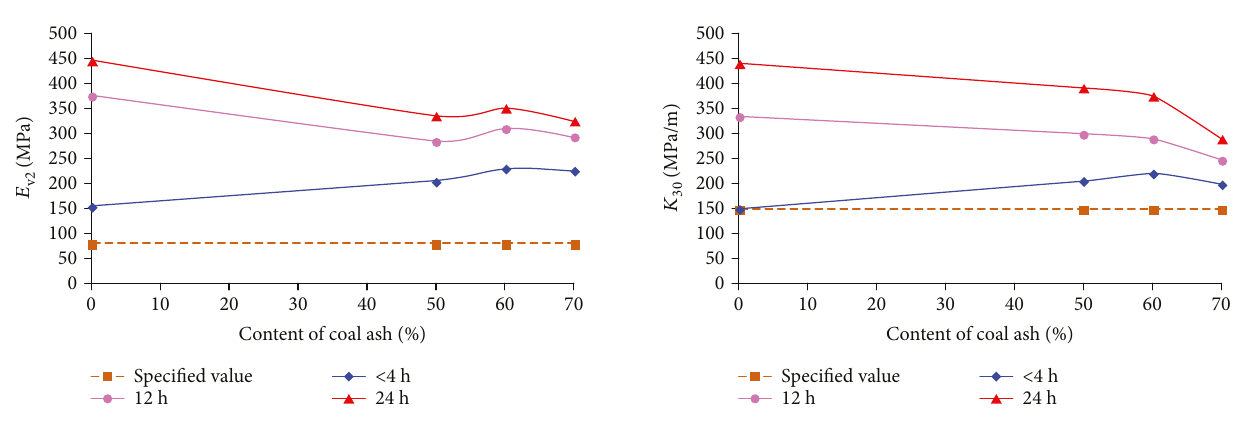
Figure 1: Relation diagram between static deformation modulus E v2 and the content of coal ash.